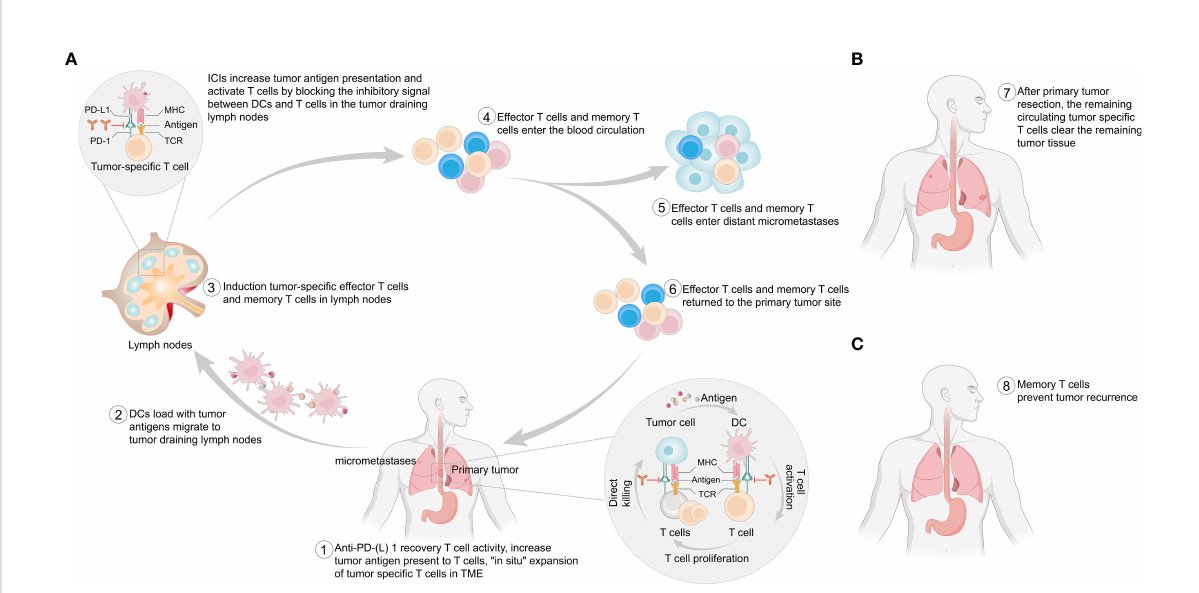
FIGURE 1 Potential mechanism of neoadjuvant immunotherapy. (A) This fi gure provides a stepwise overview of the potential mechanism of the antitumor effect of ICIs in the presence of a primary tumor. (B) After surgical removal of the primary tumor, T cells in the blood circulation can continue to exert antitumor effects to clear any remaining tumor cells. (C) After surgical removal of the primary tumor, immune memory cells prevent any postoperative recurrence and metastasis. PD-1, programmed cell death protein 1; PD-L1, programmed cell death 1 ligand 1; MHC, major histocompatibility complex; TCR, T-cell receptor; TME, tumor microenvironment; DCs, dendritic